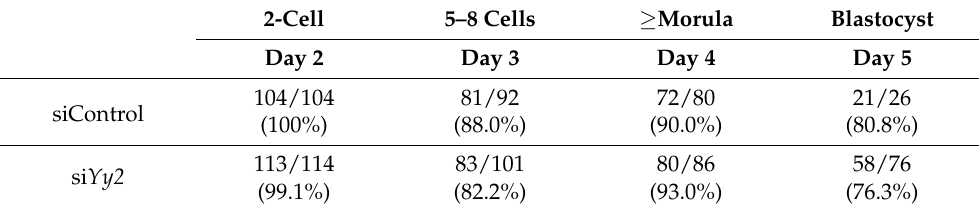
Table 1. Developmental progress assessment of Yy2 -depleted preimplantation embryos.